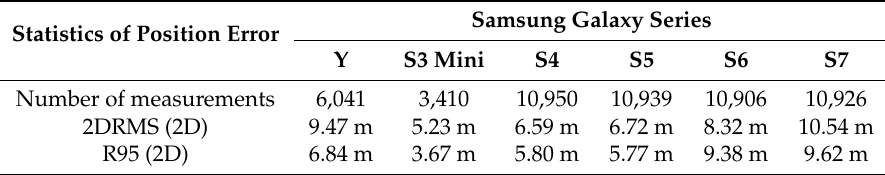
Table 3. Statistics for the Samsung Galaxy phones’ predicted position errors over the course of a dynamic measurement campaign [36].